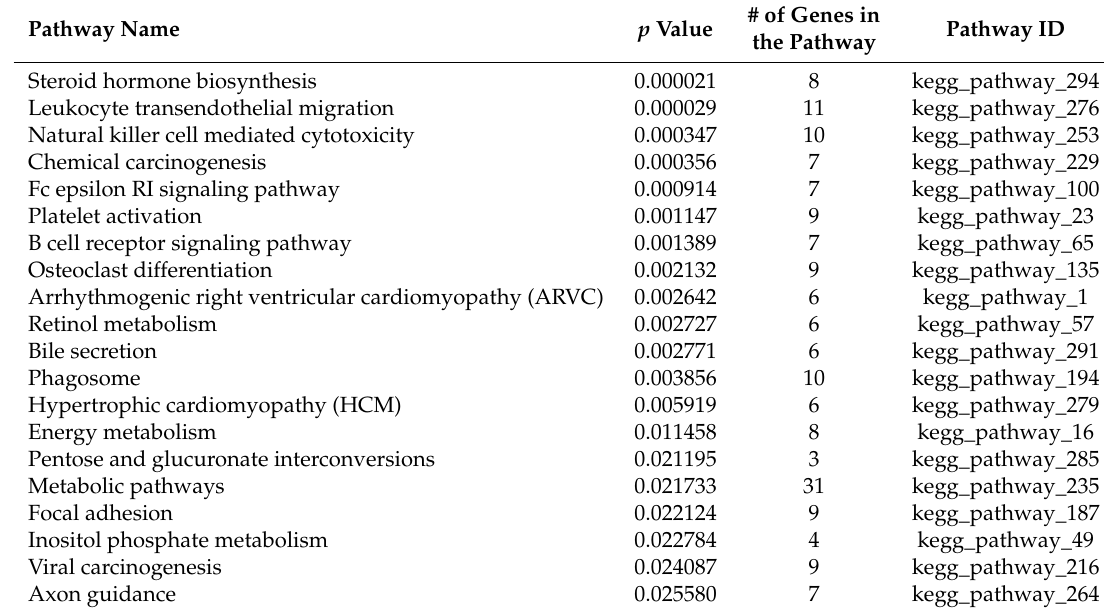
Table 2. Results of pathway enrichment analysis on the 452 genes differentially expressed in the miR-29a-BDL vs. miR-29a-Sham comparison